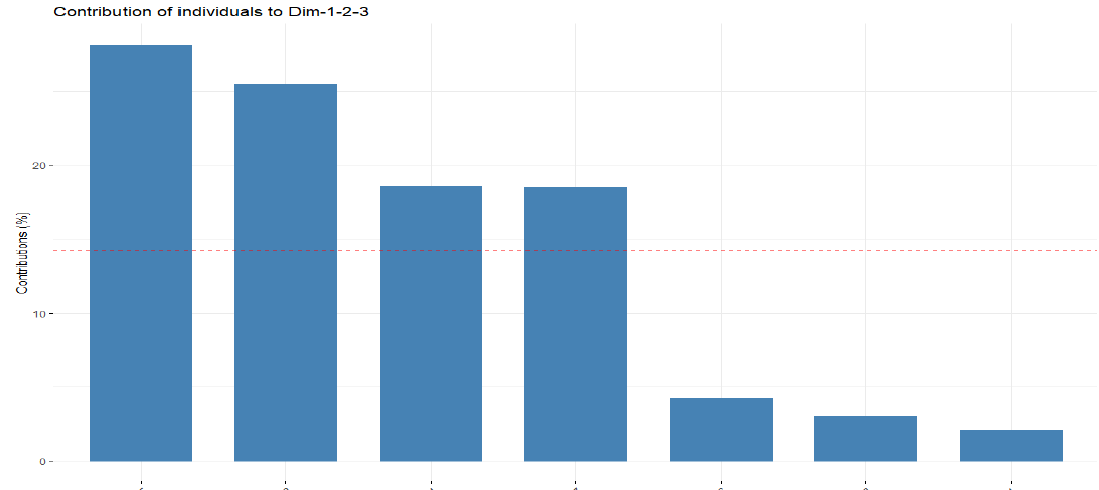
Figure 17. Diagram of the contribution of individuals in the PCA associated with the climatology of the parameters studied in relation to dimensions 1, 2 and 3.